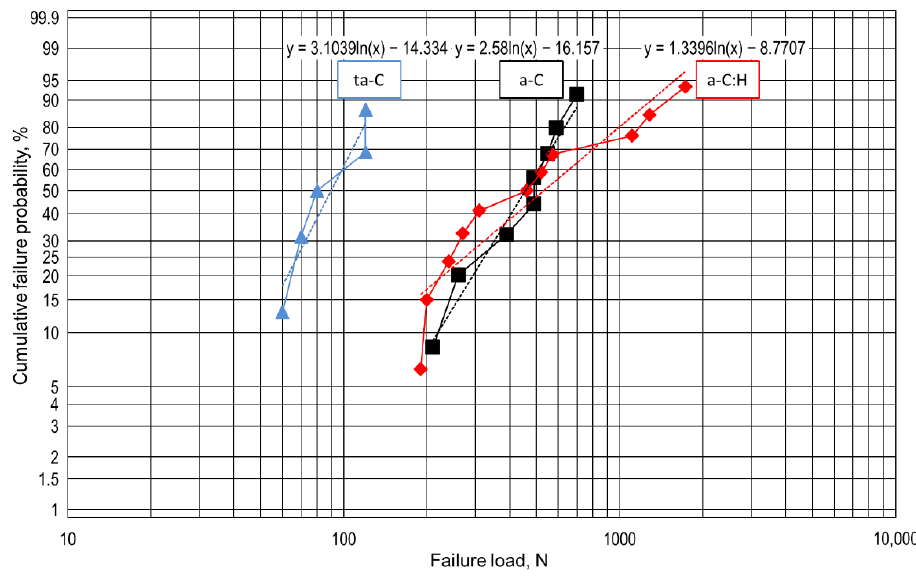
Figure 9. Weibull plot of failure load on DLC films (a-C, a-C:H, and ta-C). Table 3. Weibull slope and failure load at cumulative failure probabilities of 10% and 50% on DLC films (a-C, a-C:H, and